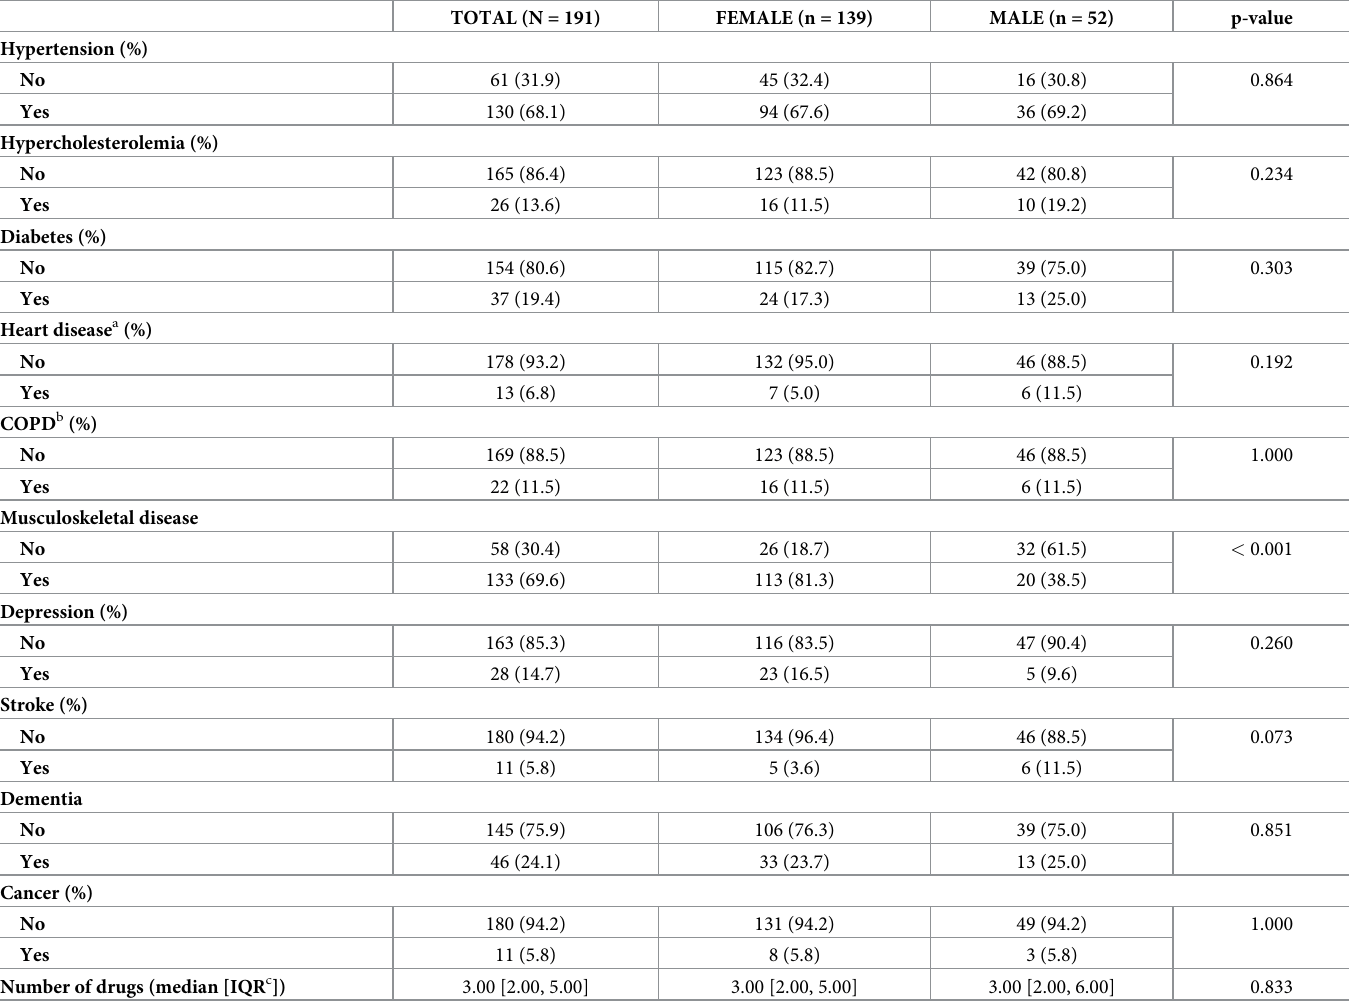
Table 2. Clinical characteristics of the